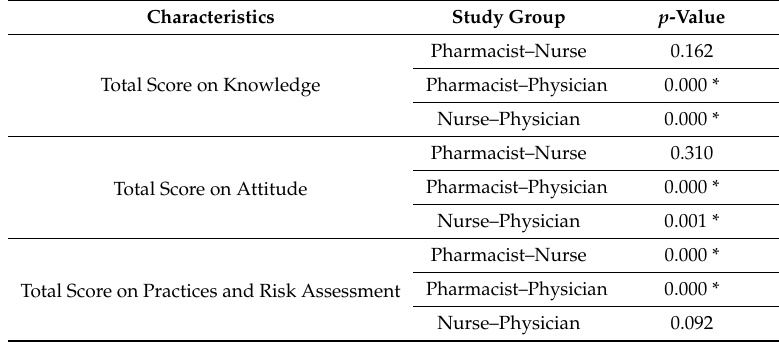
Table 5. Intergroup analysis (Kruskal–Wallis independent sample test).